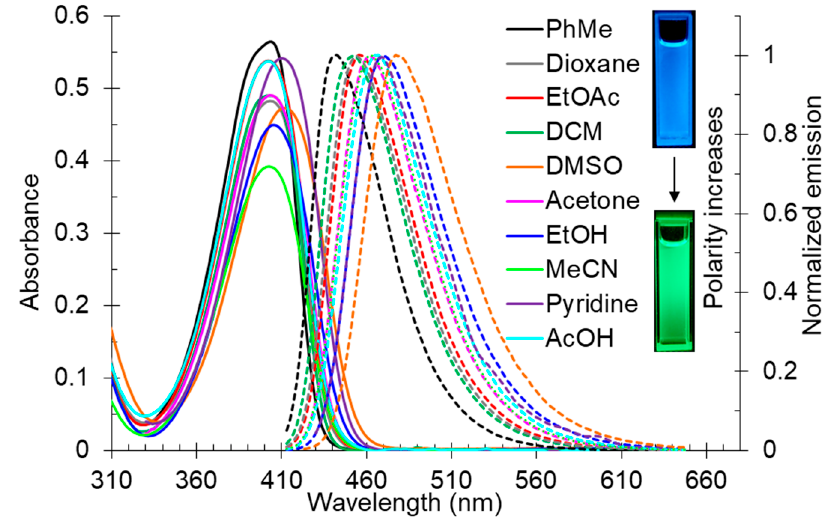
Figure 1. UV-vis absorption (5 × 10 − 5 M, solid lines) and emission (5 × 10 − 5 M, dashed lines) spectra of compound 2d in various solvents. Photos of solution 2d in toluene and DMSO were taken under 365 nm of irradiation.